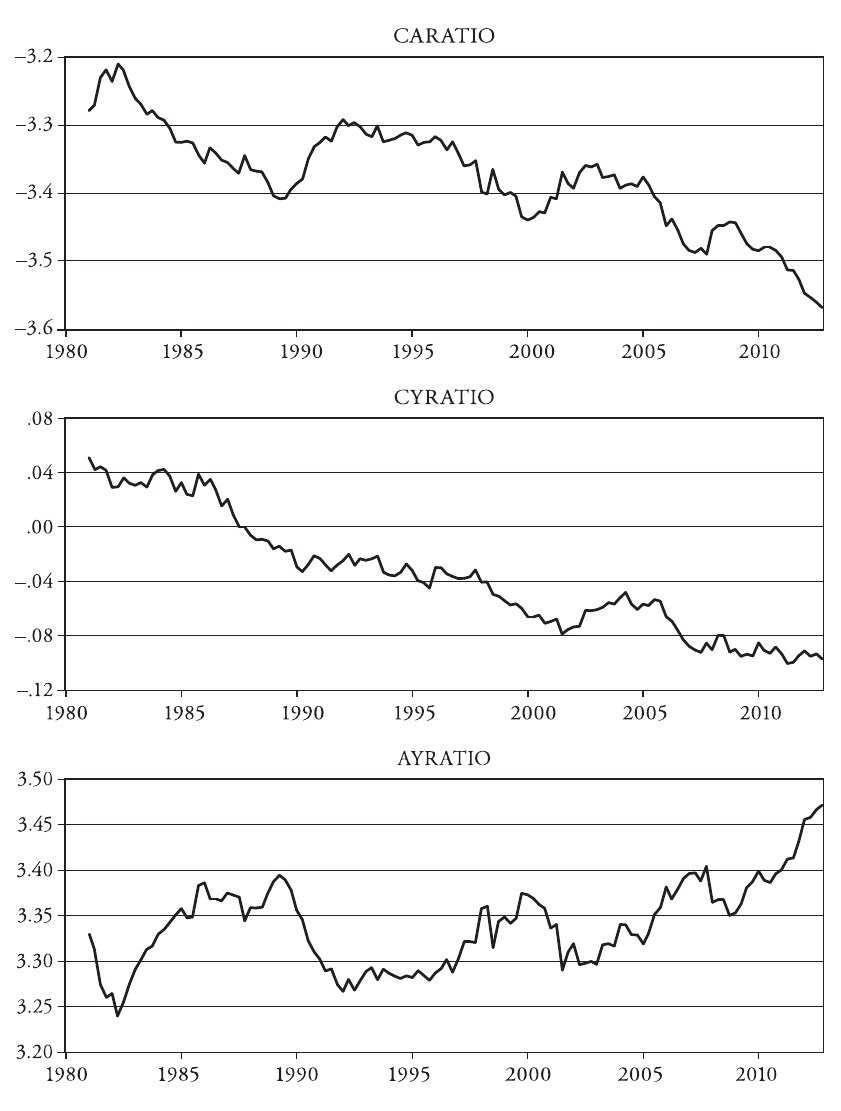
Figure 11: The Great Ratios fur Switzerland (in